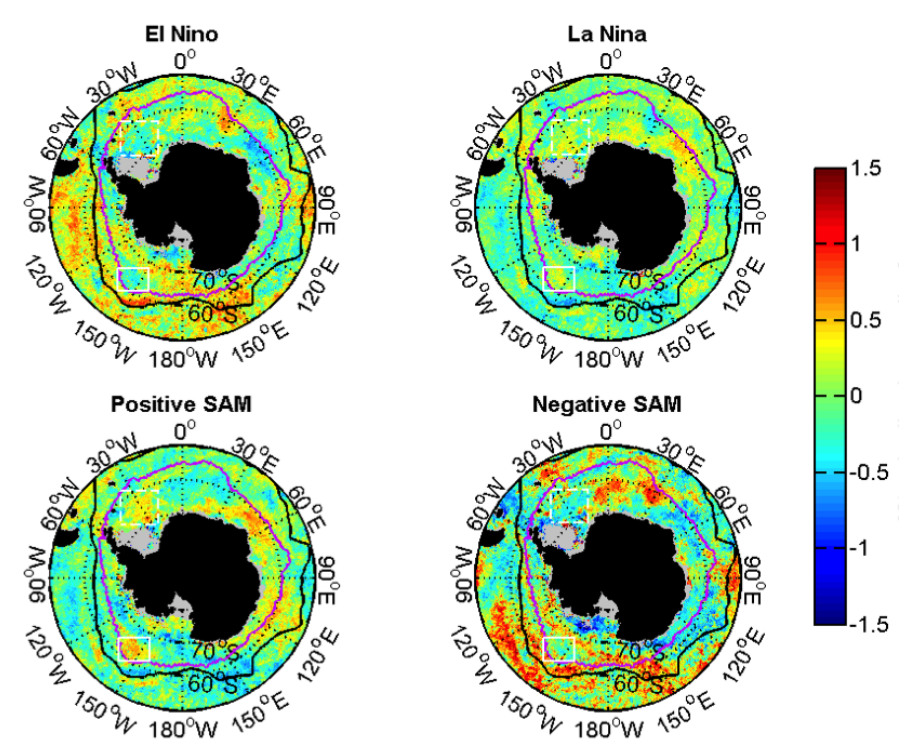
Figure 10. Same as Figure 9 but for Dia-Chla